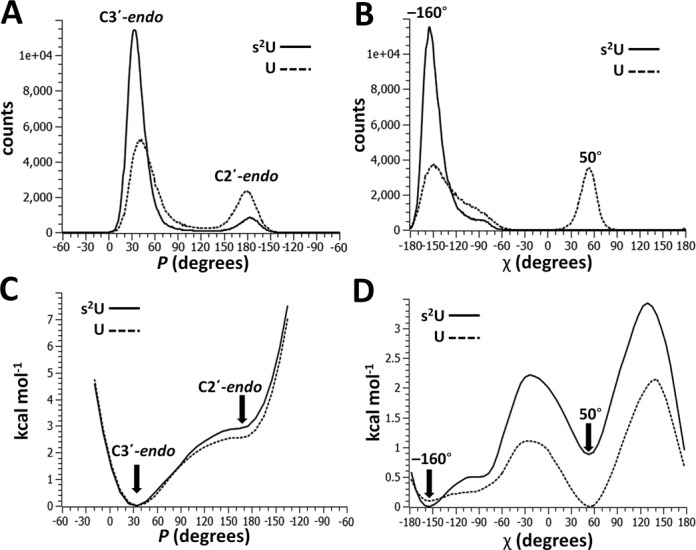
MD simulations and umbrella sampling of U and s2U nucleosides at 25°C. (A) Conformation histogram of the pseudorotation phase angle (P). s2U spends a larger proportion of time in the preferred C3′-endo conformation; (B) Conformation histogram of chi angle (χ). s2U almost exclusively occupies a χ of ∼–160° while U spends a significant portion of the simulation occupying a χ of ∼50°; (C) Free energy landscape for P. Energy minima appear at values corresponding to C3′-endo and C2′-endo conformations. The barrier separating these conformations is larger for s2U; (D) Free energy landscape for χ. Energy minima appear at values corresponding to ∼–160° and ∼50°. The barrier separating these conformations is, again, larger for s2U.